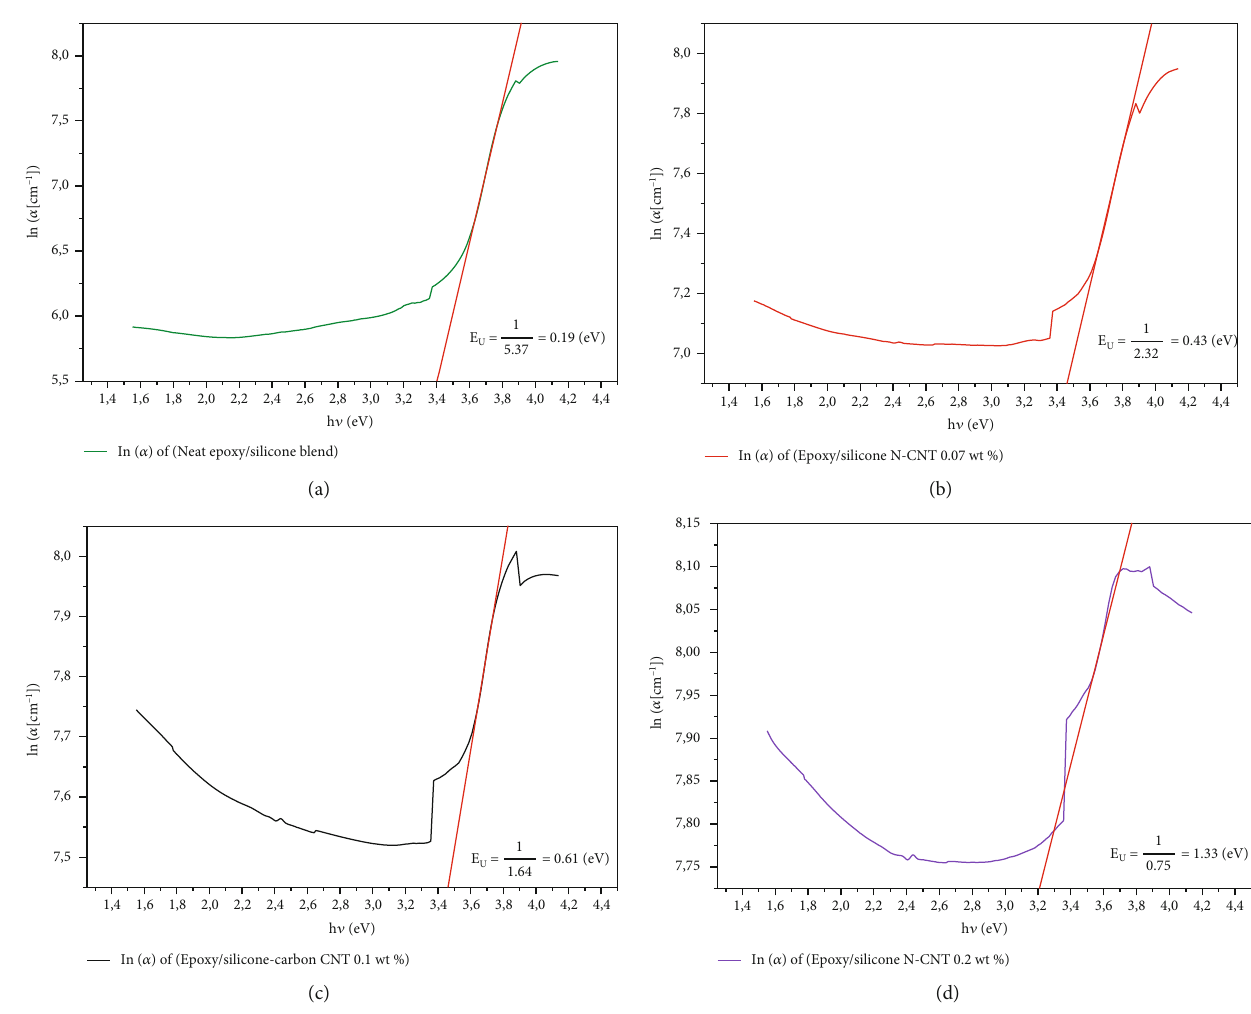
Figure 5: Determination of Urbach energy E 0.07, 0.1, and